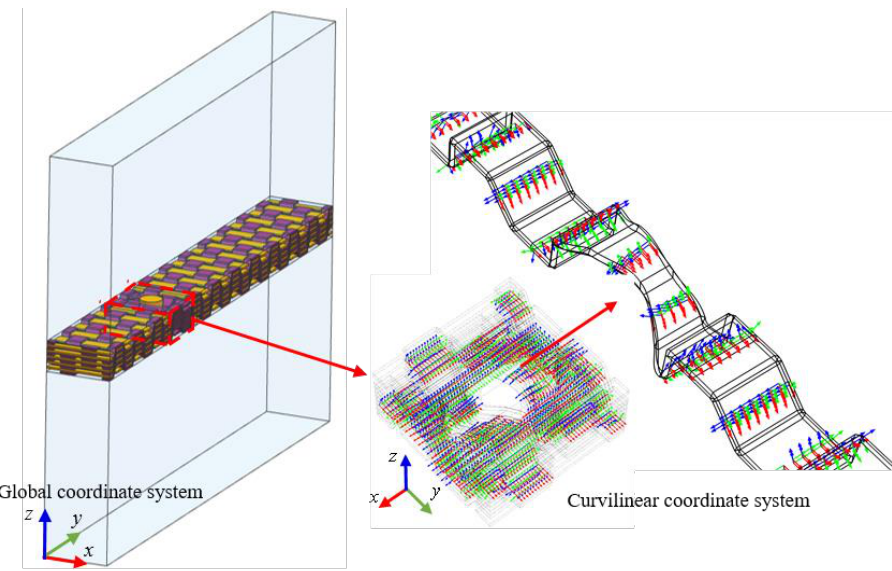
Figure 6. Schematic diagram of calculated coordinates.